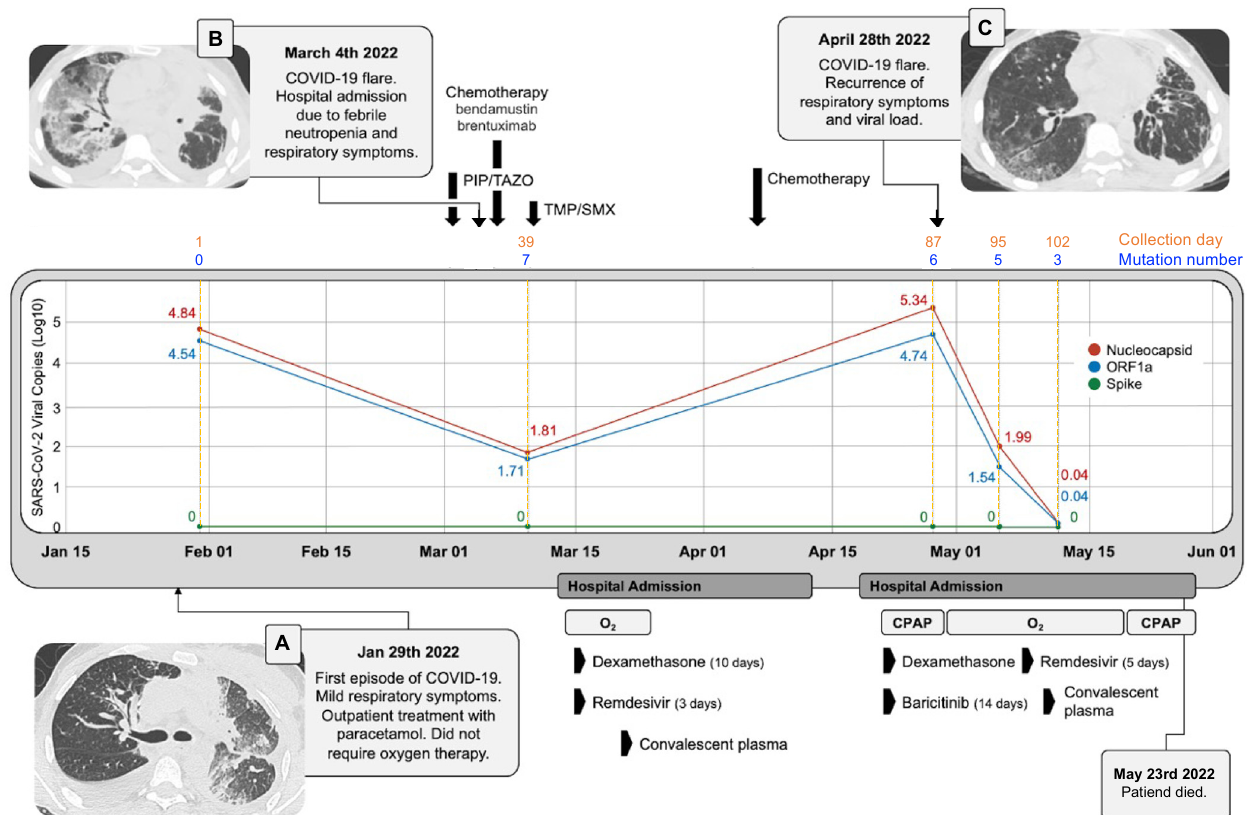
Figure 1. Clinical course and viral load. Timeline of clinical course and SARS-CoV-2 viral load across the five different collection days. The copy number in LOG10 of the three viral genes detected in RT-qPCR is shown. N: Nucleocapsid, S: spike and ORF1a. Solid lines correspond to calendar days and dashed orange lines correspond to elapsed days. The number of mutations per collection date including only those mutations that change their presence/absence status over time is shown per each collection date. Panel ( A ). Chest CT of the first flare. Panel ( B ). Chest CT at COVID-19 diagnosis. Panel ( C ). Chest CT of the second flare.